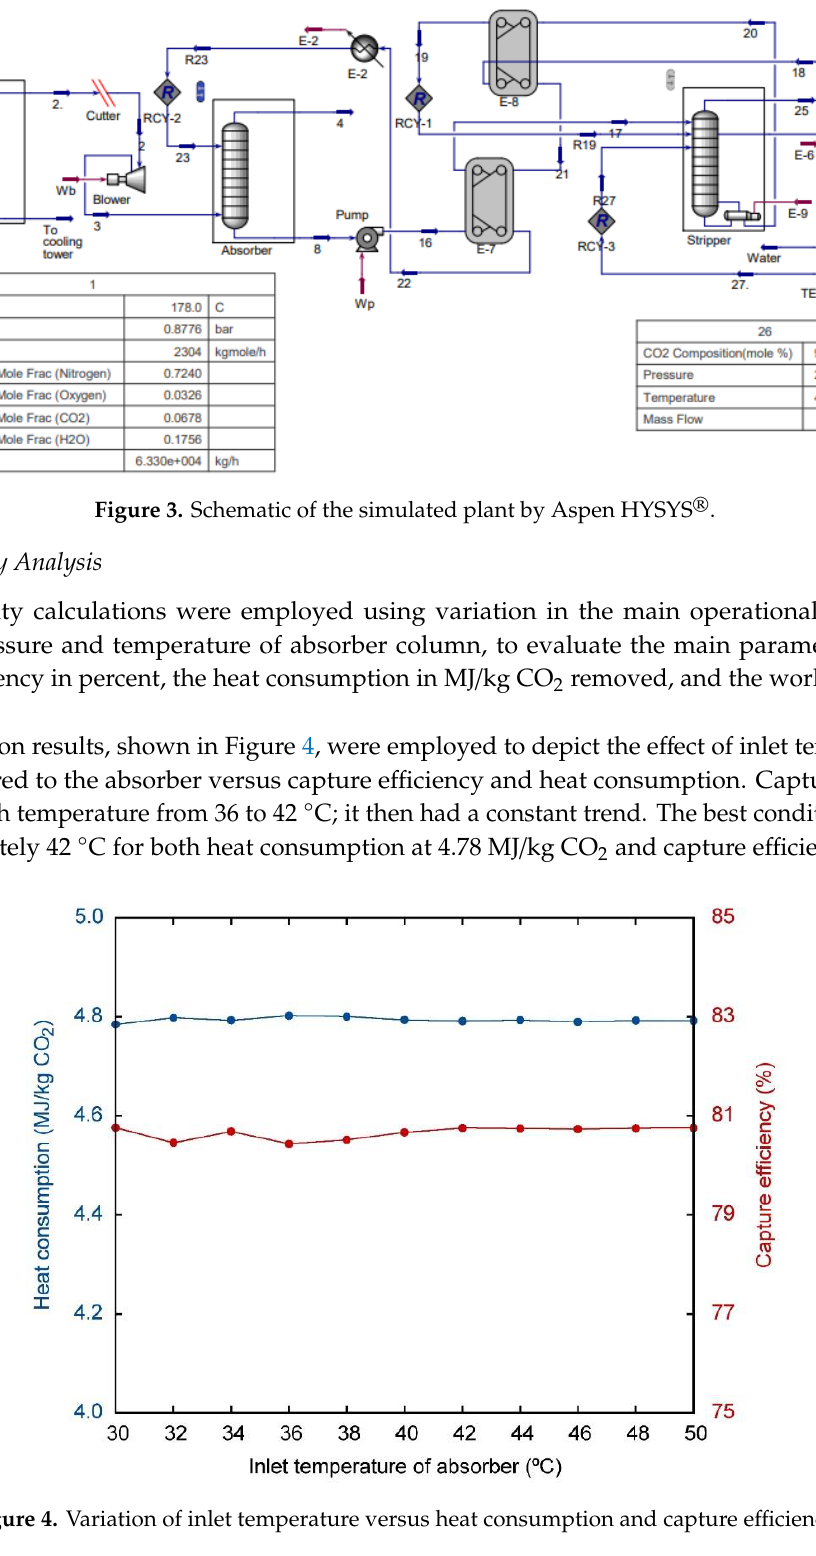
Table 5. Validation of simulated results with important parameters of the CCU plants.